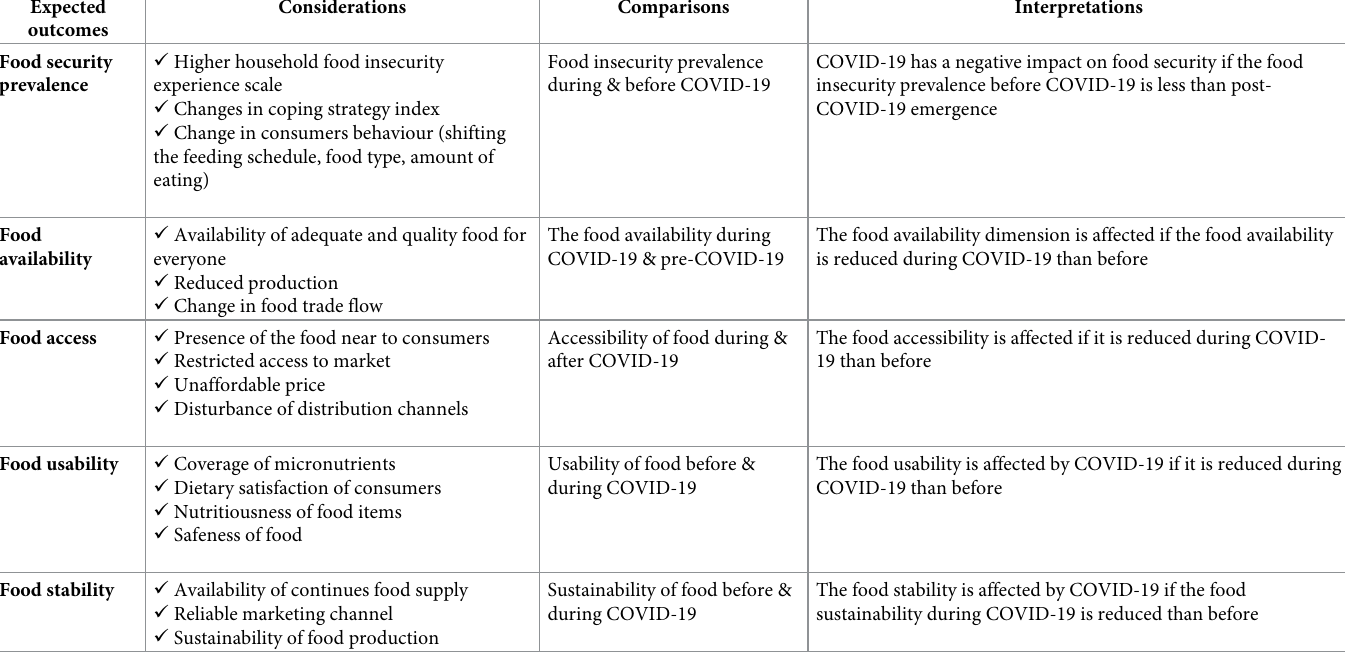
Table 2. The expected outcomes, considerations, comparisons, and